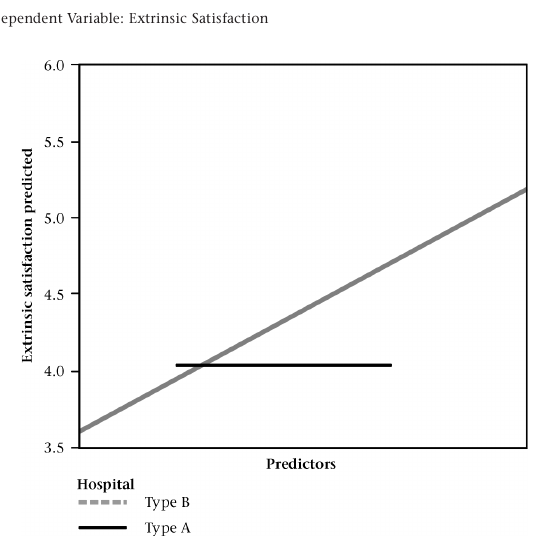
Figure 5: Predictors of Extrinsic Satisfaction Based on the obtained statistical parameters of the different predictor variables, the following equation was formulated to predict